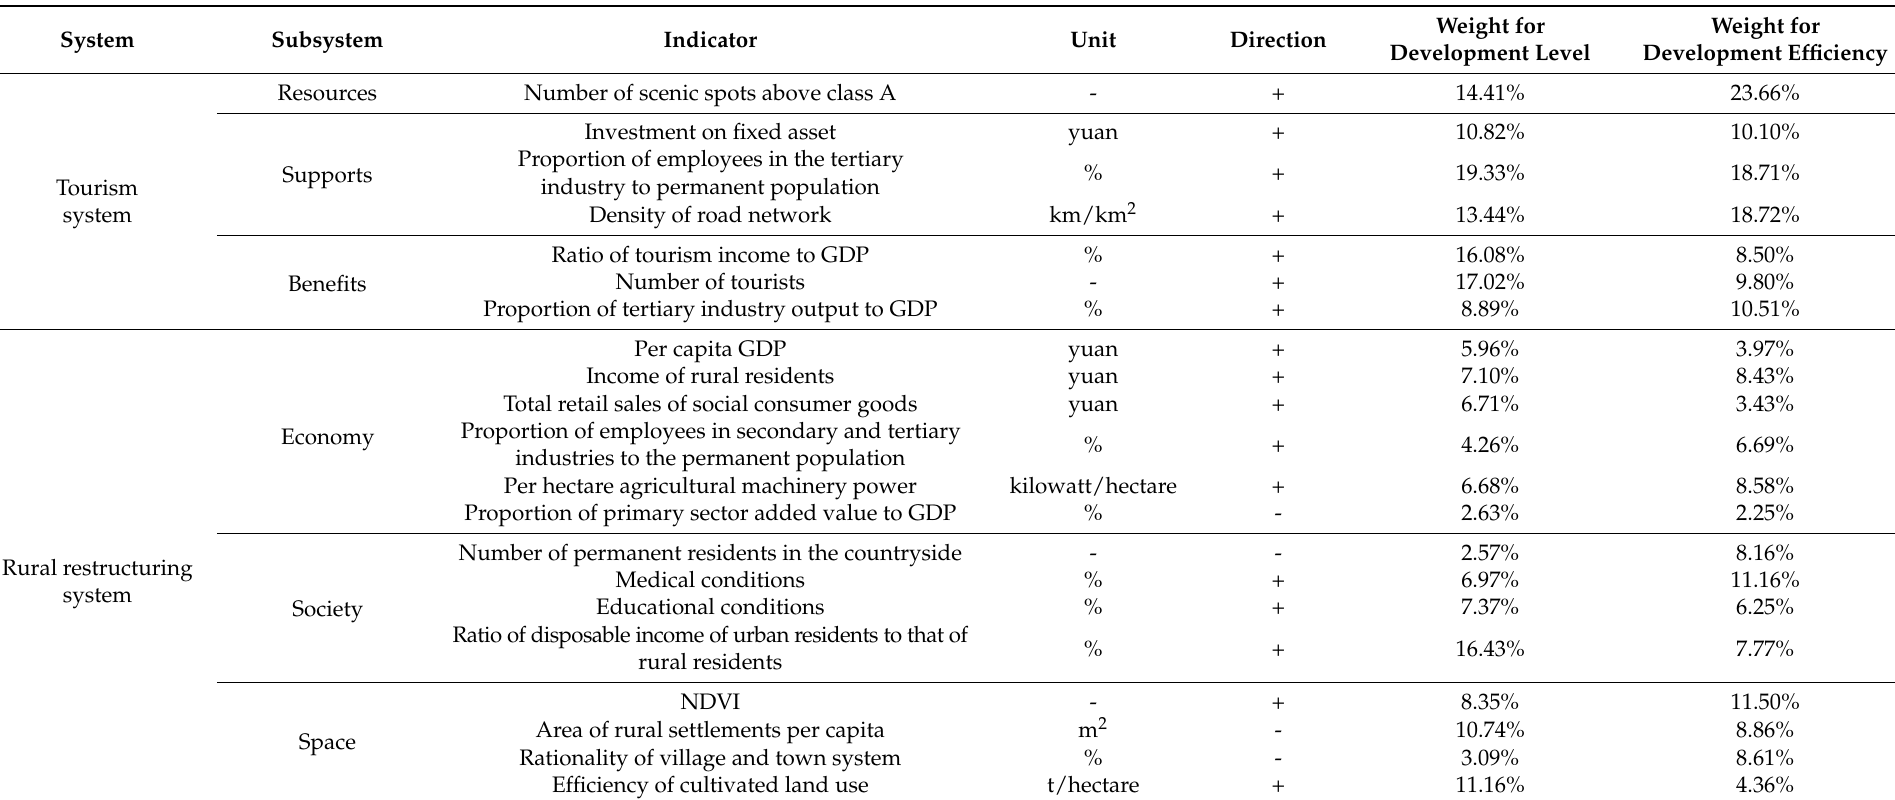
Table 1. Indicators for tourism and rural development level and